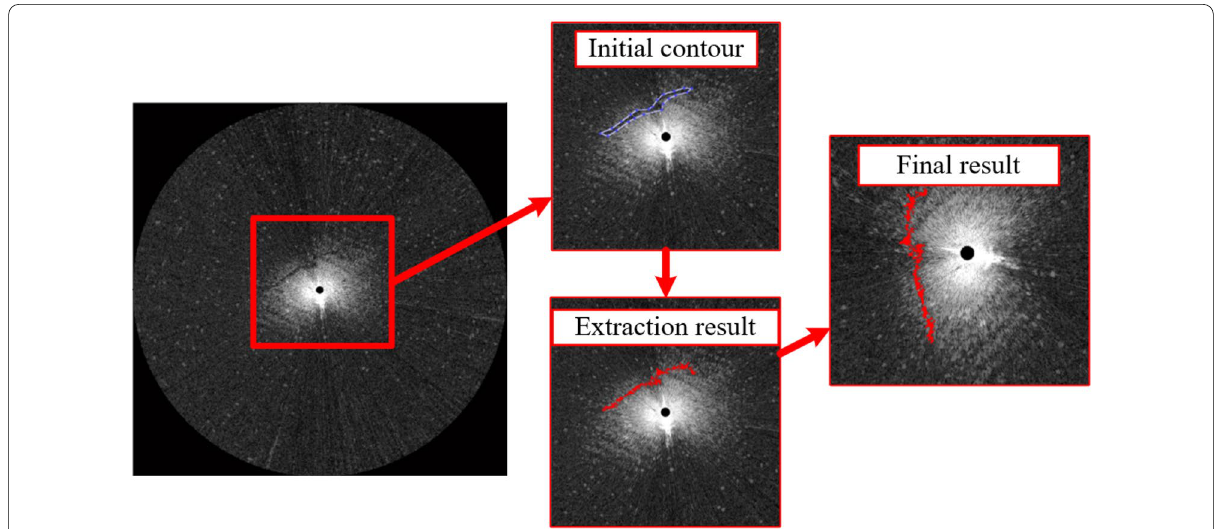
Fig. 7 Suspected oil films extraction by an improved LBF